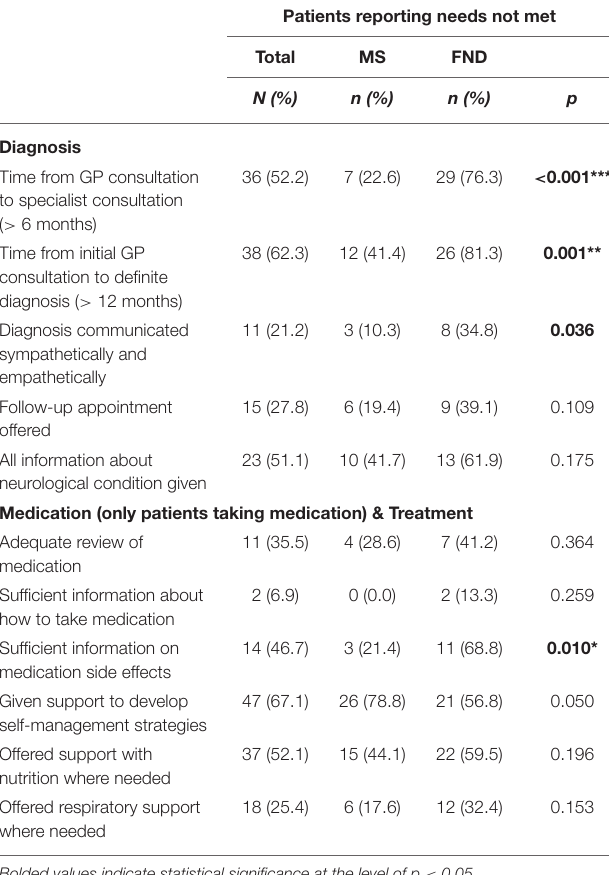
TABLE 2 | Patients reporting a problem regarding the health and social care of their neurological condition. Patients reporting needs not